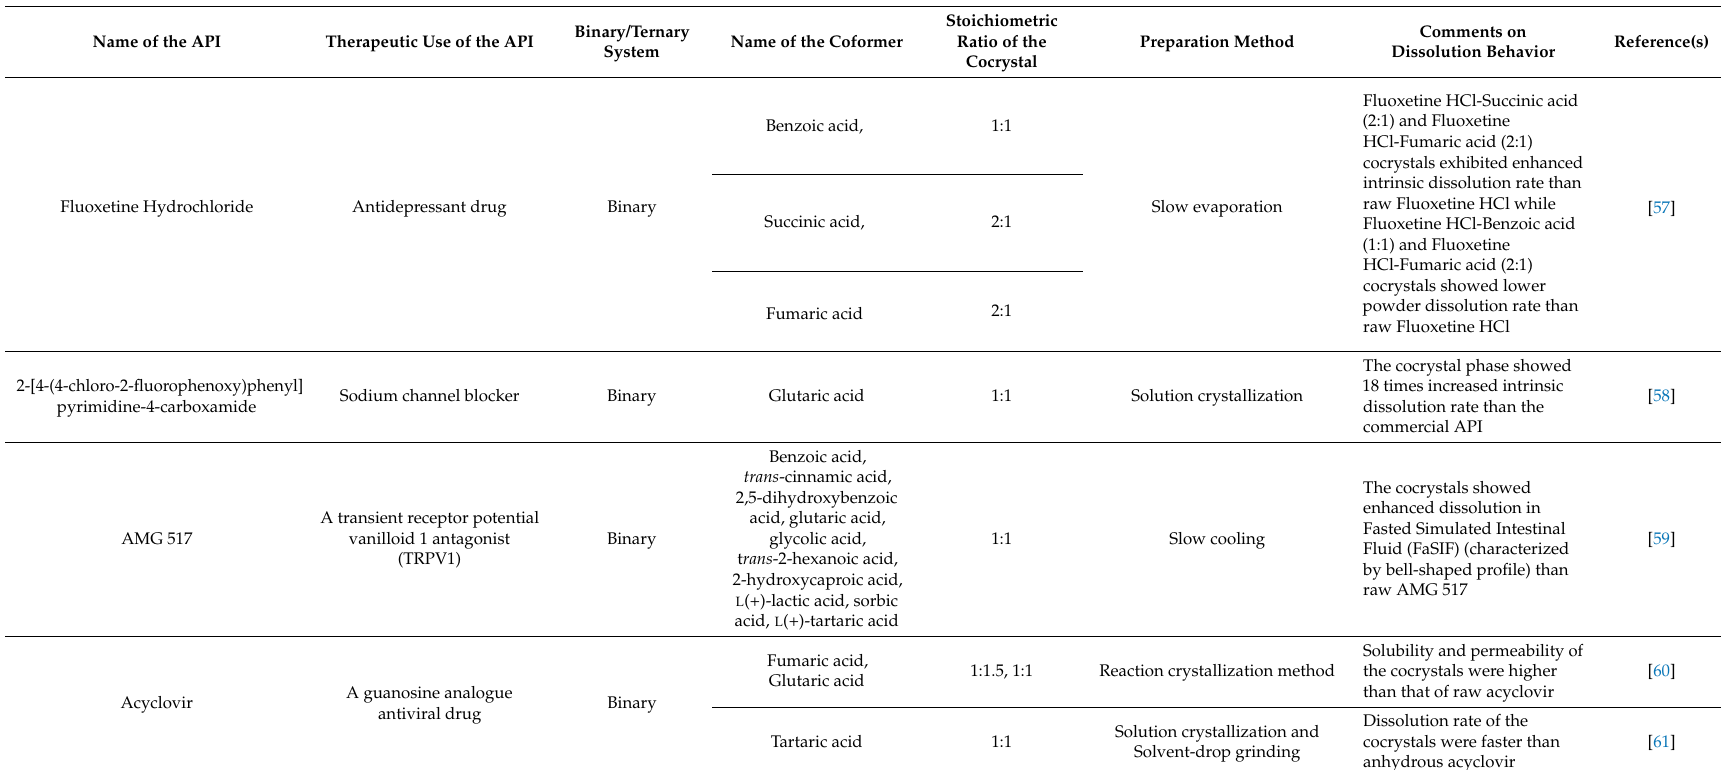
Table 2. Summary of a few literature reports on representative pharmaceutical